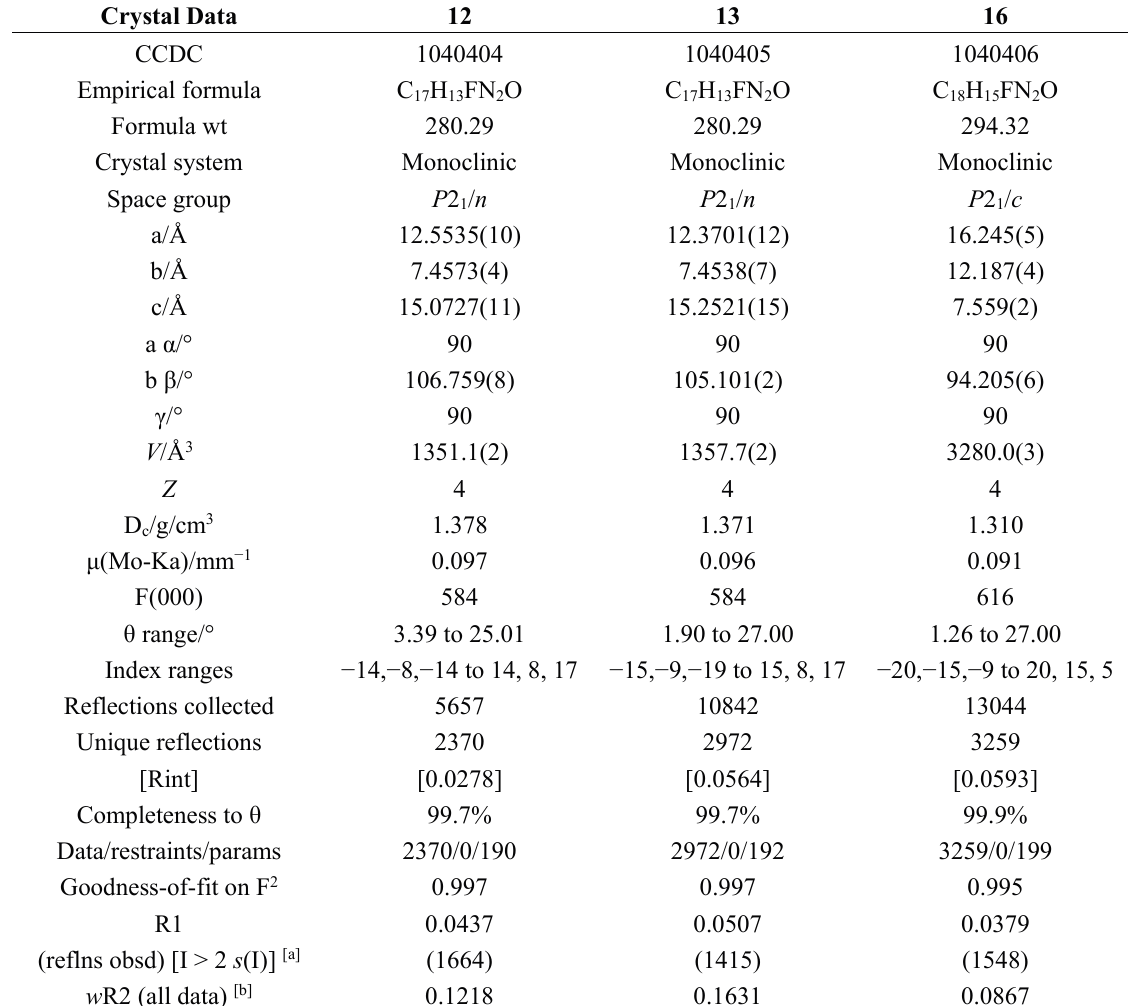
Table 6. Crystal data and Refinement Data for 12 , 13 and 16